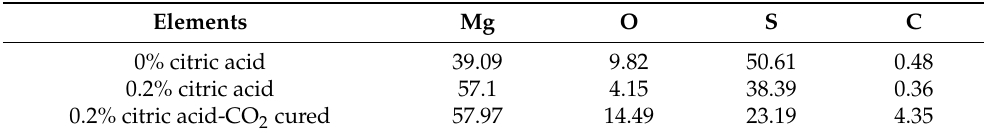
Figure 13. SEM-EDS of specimens. ( a ) 0% citric acid. ( b ) 0.2% citric acid. ( c ) 0.2% citric acid-CO 2 cured. Table 2. The element distribution obtained by EDS (%).